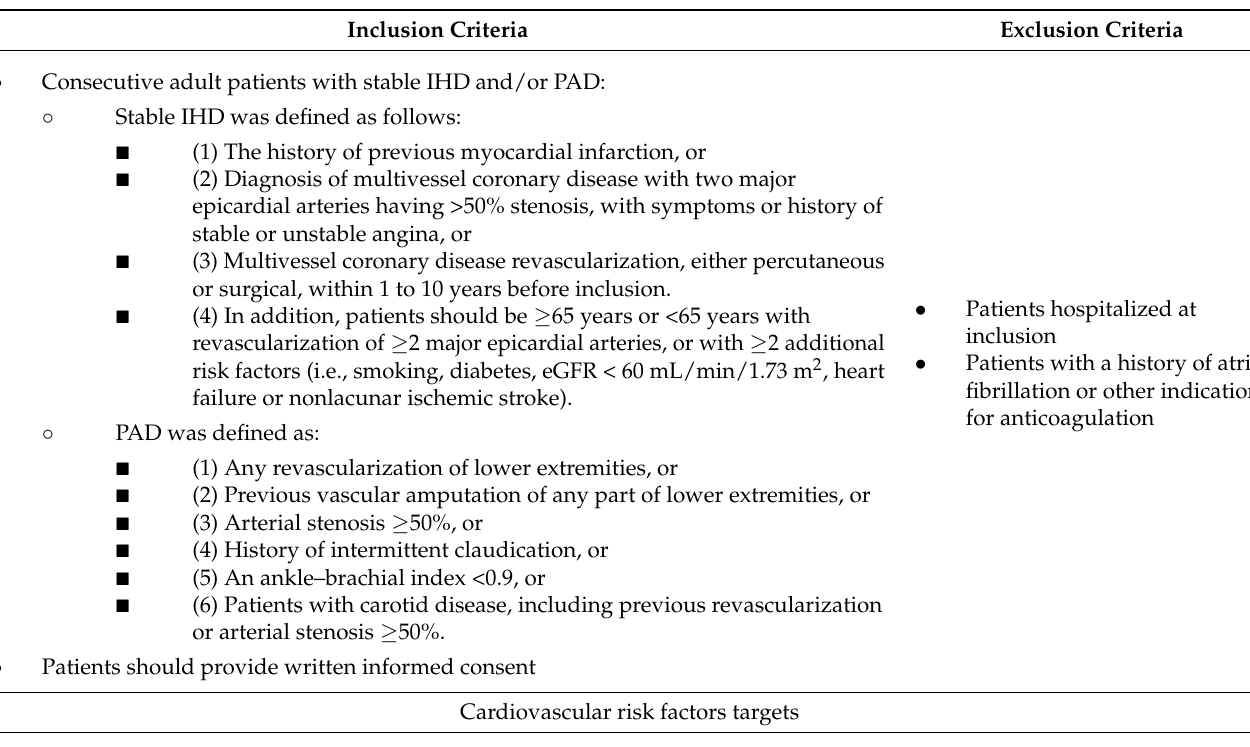
Table 1. Inclusion/exclusion criteria and cardiovascular risk factors